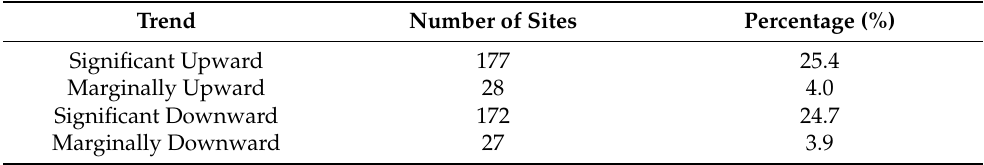
Table 1. The number of meteorological sites and percentage in each trend type. Trend